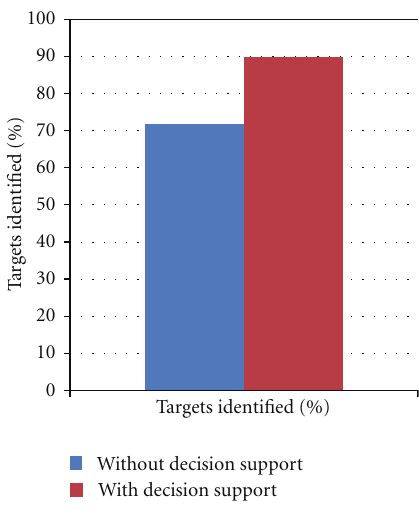
Figure 7: Targets identified.